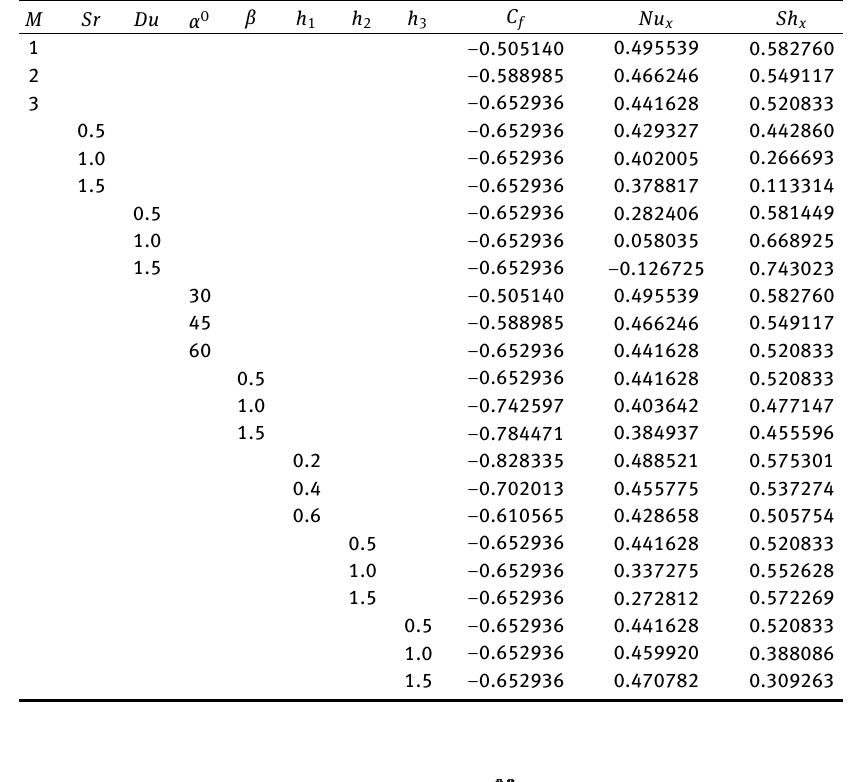
Table 1: Variations in physical quantities for the flow over a variable thickness sheet M